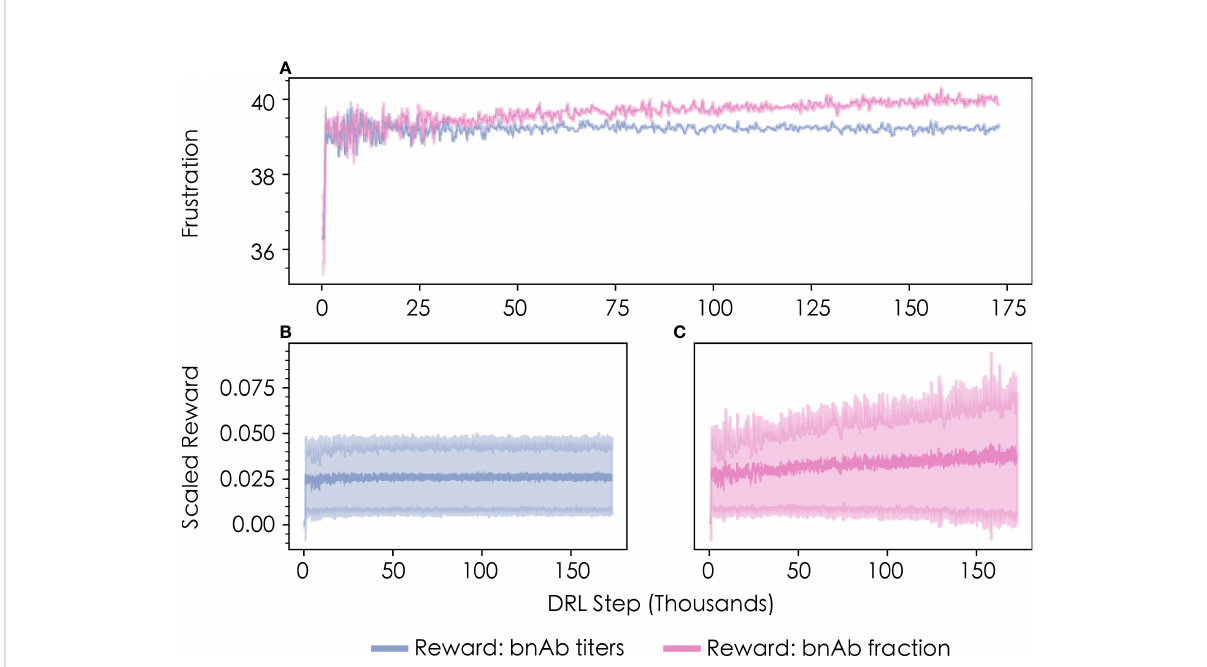
FIGURE 3 Convergence pro fi les of (A) the level of frustration imposed on GC reactions in the fi rst vaccine immunization, as chosen by the DRL agent, and (B, C) the corresponding scaled reward values obtained by the DRL agent. Results are shown in blue for the bnAb titers reward function, and in pink for the bnAb fraction reward function. The data shown represents a rolling average with 500 DRL steps for both the mean and standard deviation (shown in lighter